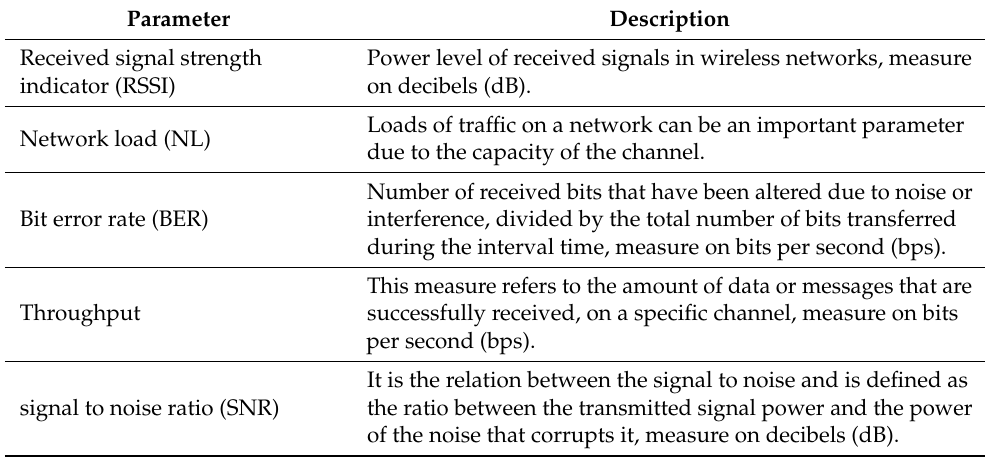
Table 1. Features commonly used in handover decision algorithms.